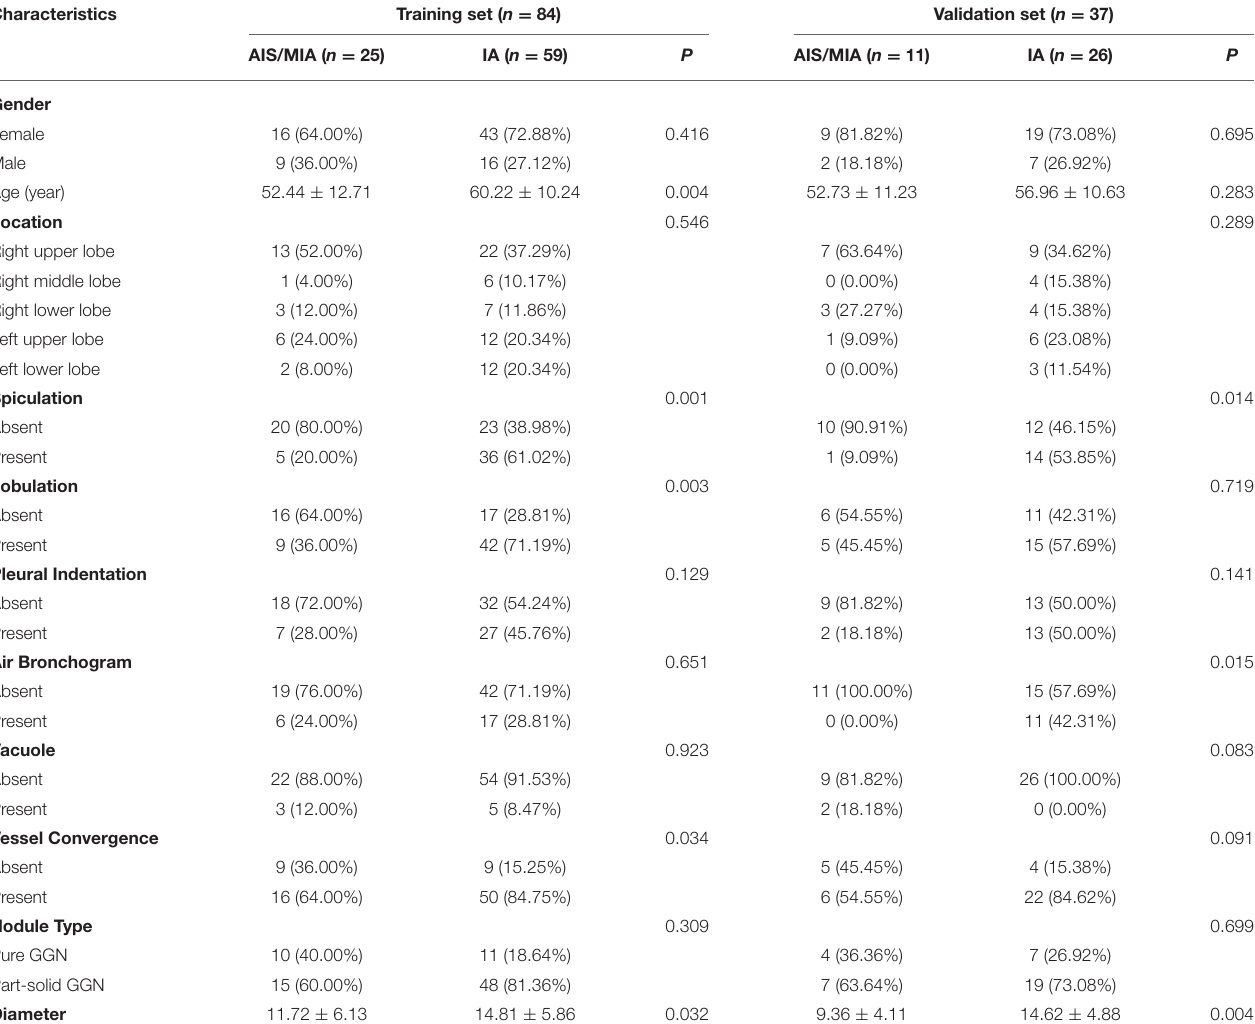
TABLE 1 | Characteristics of the training and validation